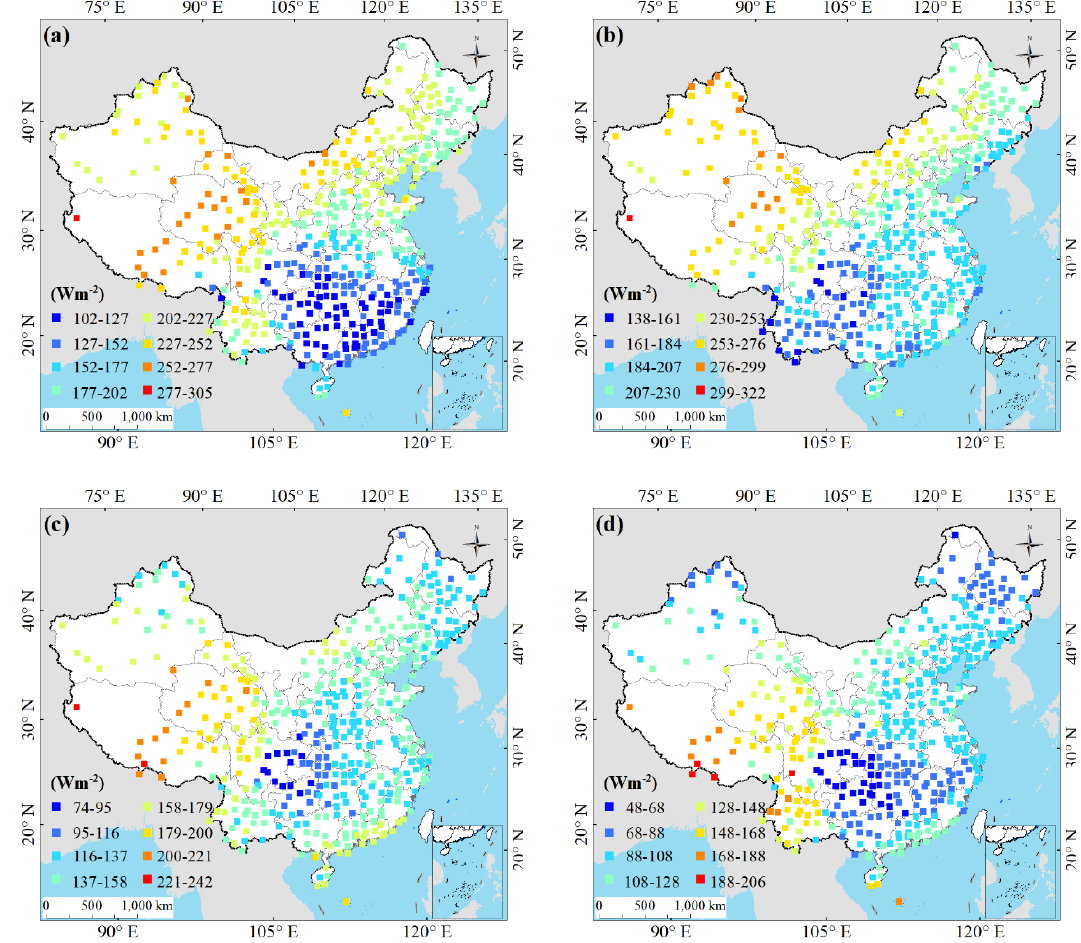
Figure 10. Spatial distribution of the seasonal mean Rs over China in ( a ) spring, ( b ) summer, ( c ) autumn, and ( d ) winter during 1970–2015.